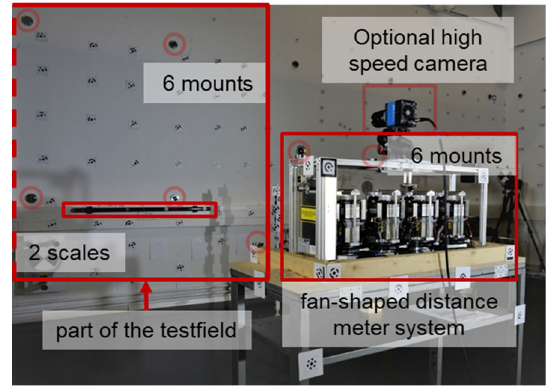
Figure 17. Measurement setup for method 1